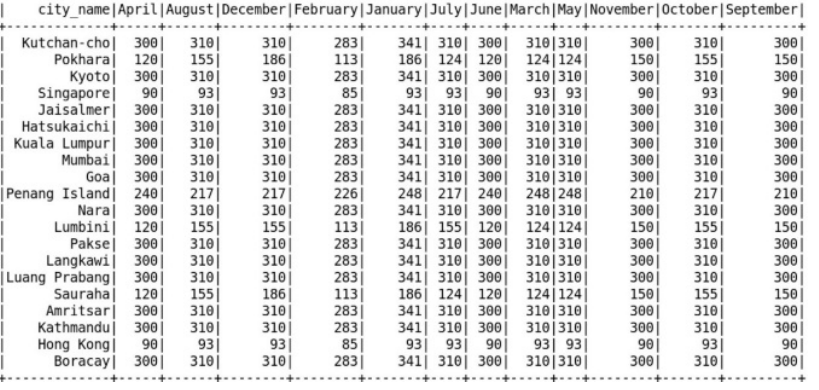
Figure 15. A summarized output showing climate data of a travel destination.